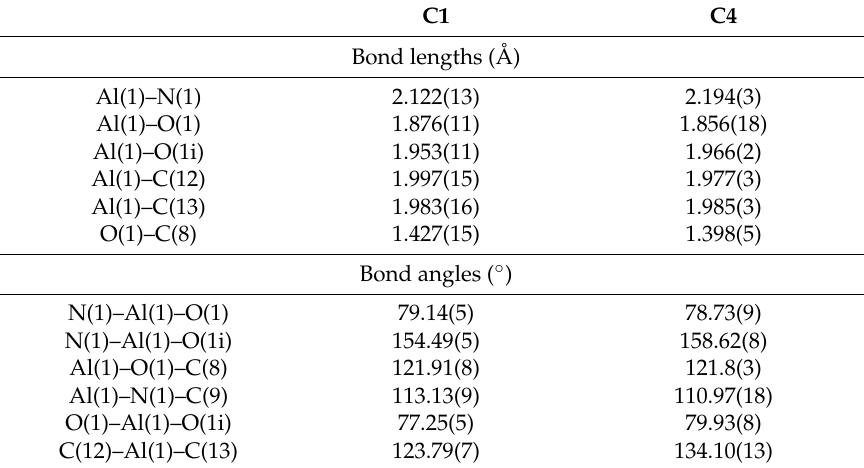
Figure 2. ORTEP representation of C4 showing the disorder in the saturated sections of the rings. Thermal ellipsoids are shown at 30% probability while hydrogen atoms have been omitted for clarity. Table 2. Selected bond lengths (Å) and angles (°) for C1 and C4.